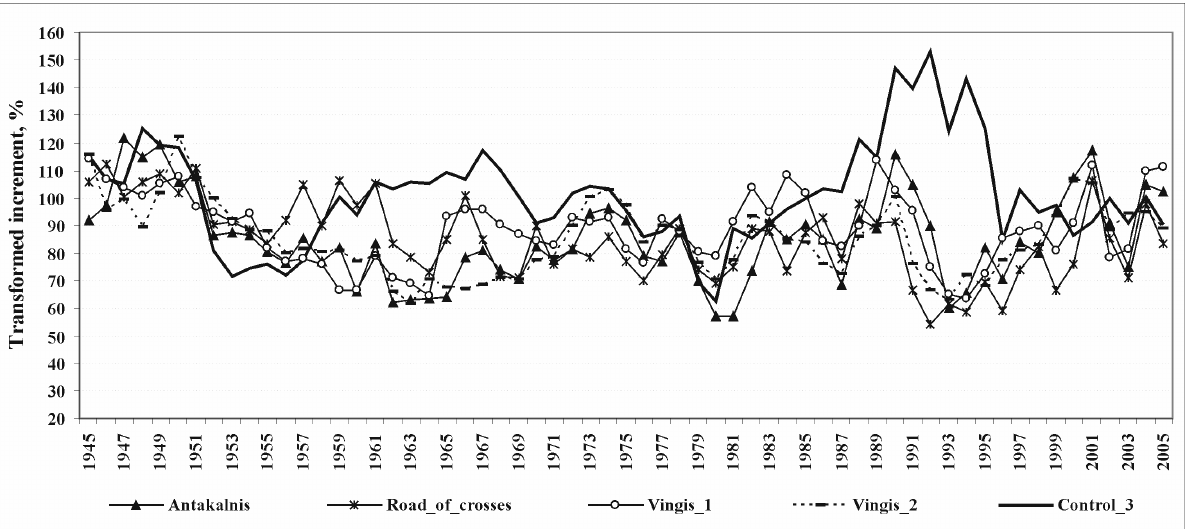
Fig. 7. Transformed dendroscales of 160-180 year old pines in Control_3 and Vilnius city sample